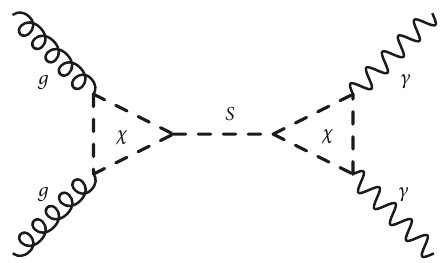
Figure 2: The Feynman diagram of the production and decay of S at the LHC through 𝜒 in the